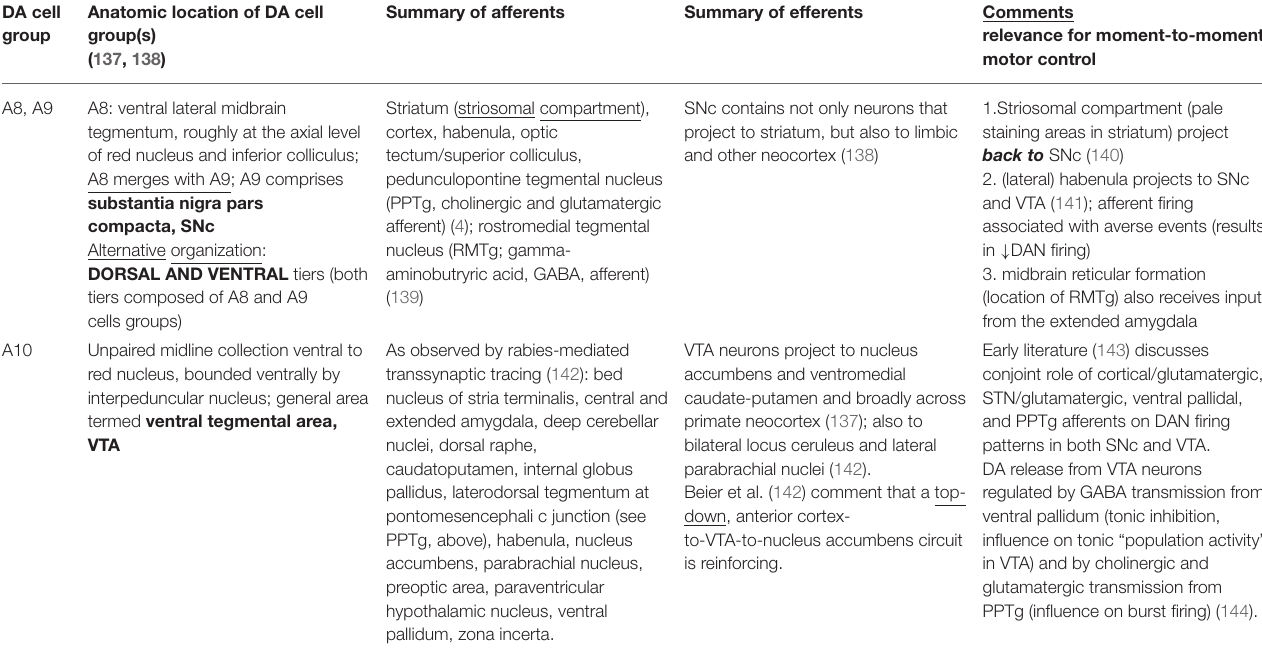
TABLE 3 | Afferents and efferents to midbrain DA cell groups, references in parentheses. DA cell